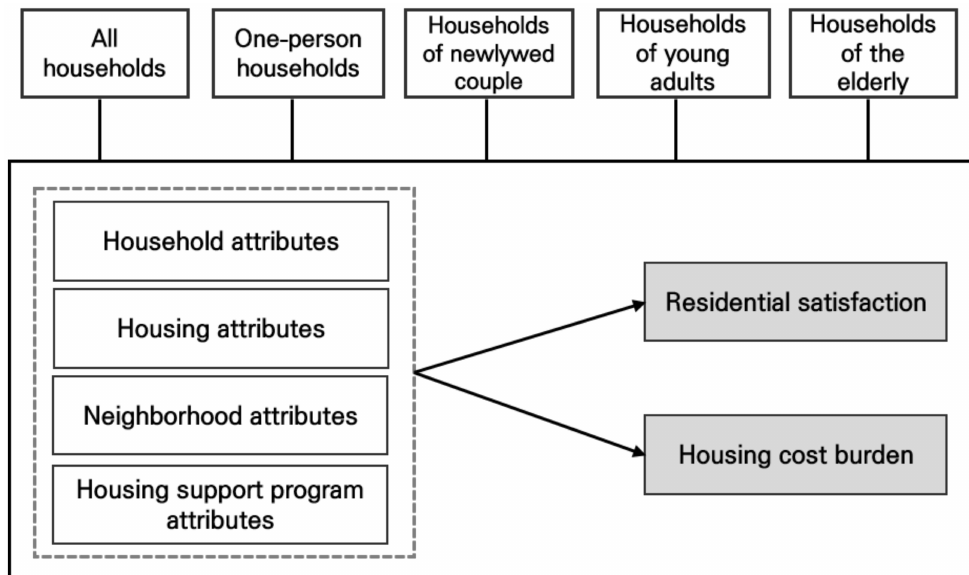
Figure 2. Conceptual